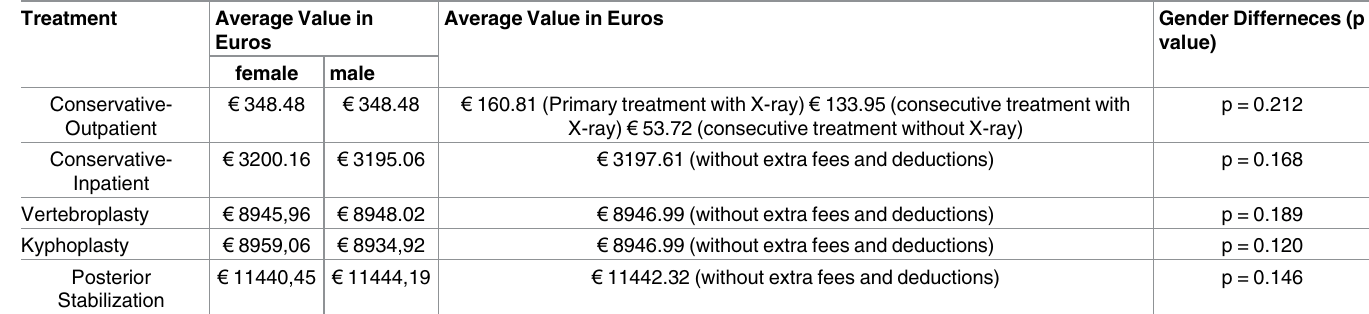
Table 5. Treatment costs. Average Treatment Costs and gender-differencesper patient relatingto the type of treatment. Treatment